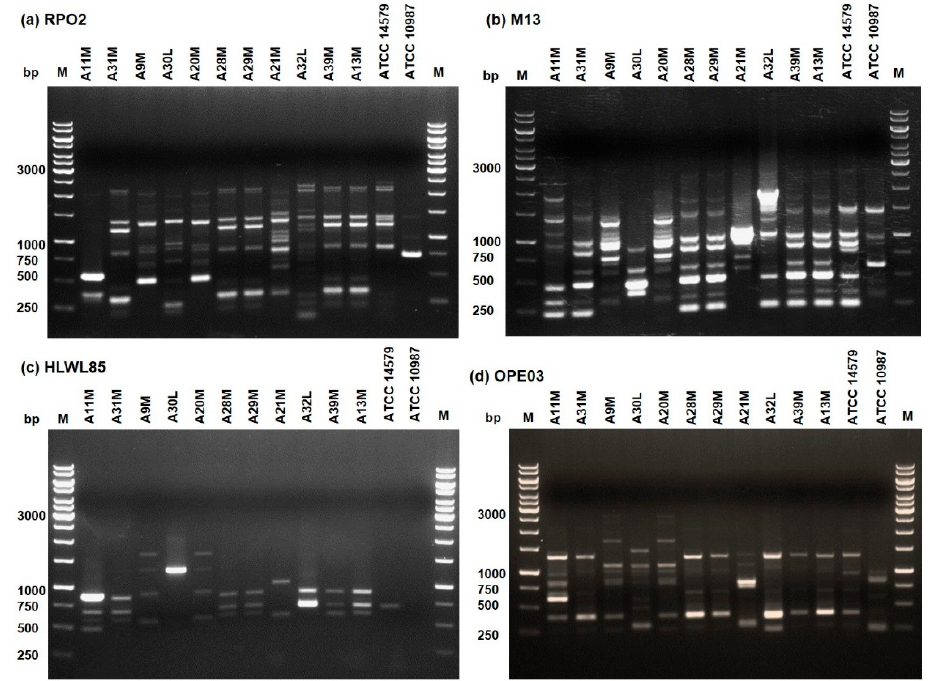
Figure 2. RAPD-PCR amplification profiles obtained with primers RPO2 ( a ), M13 ( b ), HLWL85 ( c ), and OPE03 ( d ) from B . cereus isolates. Genomic DNA extracted from the reference strains B. cereus ATCC 14579 and B. cereus ATCC 10987 was used as control of each reaction. M = Thermo Scientific GeneRuler 1 kb DNA Ladder (Thermo Fisher Scientific, MA, USA). Numbers on the left margins of each panel indicate the position of the molecular weight standards (bp).